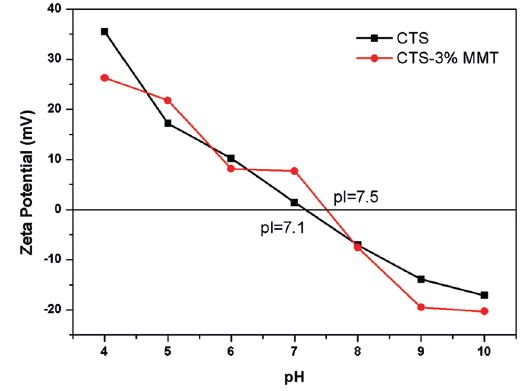
Figure 2: Zeta potentials of the CTS and CTS-3%MMT composite beads.